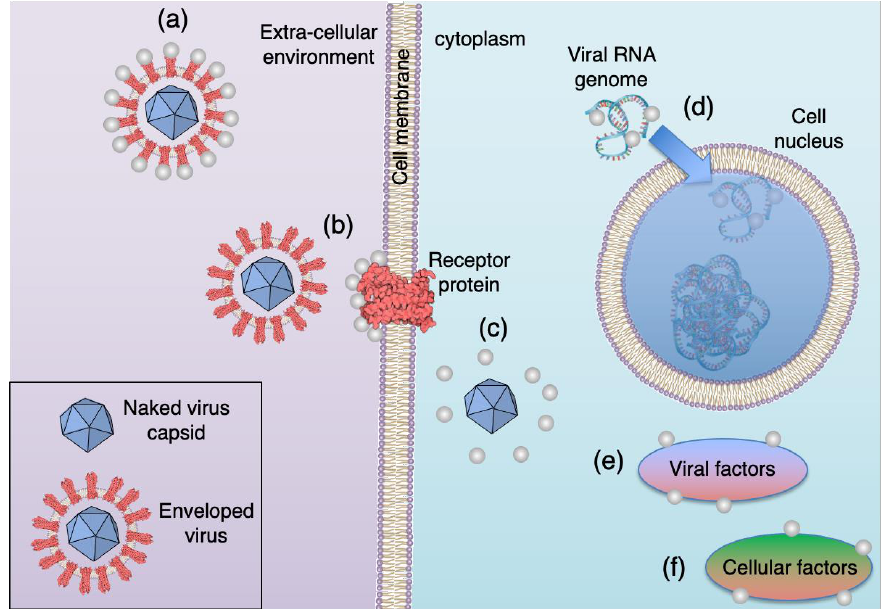
Figure 1. Antiviral mechanisms of Ag nanoparticles. ( a ) Ag nanoparticles interact with the viral envelope and/or viral surface proteins and prevent virus from docking with the cell. ( b ) Ag nanoparticles interact with cell membrane receptors and block viral penetration. ( c ) Ag nanoparticles block cellular pathways of viral entry preventing the genome reaching the nucleus ( d ) Ag nanoparticles interact with the viral genome and prevent it from being used to manufacture proteins. ( e ) and ( f ) Ag nanoparticles interact with viral and cellular factors necessary for viral replication. Reproduced with permission from [17]. Copyright 2022, Wiley.